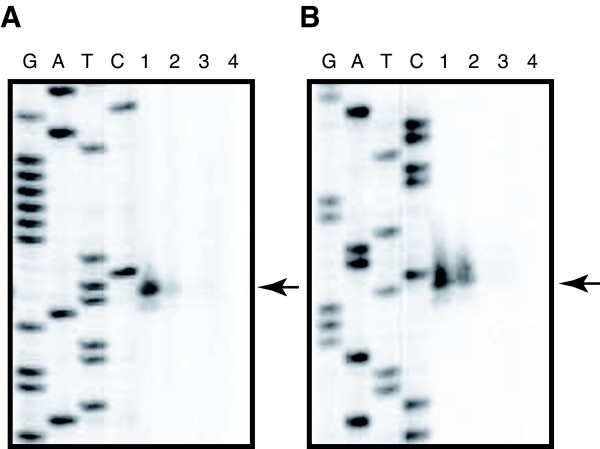
Mapping of the transcription start sites for ORF100 (A) and ORF145 (B). Primer extension was performed using equal amounts of total RNA from KT2440(pCAR1) grown on succinate (lane 1) or carbazole (lane 2) and from CA10 grown on succinate (lane 3) or carbazole (lane 4). Lanes G, A, T, and C indicate the sequence ladder obtained using the same primer.